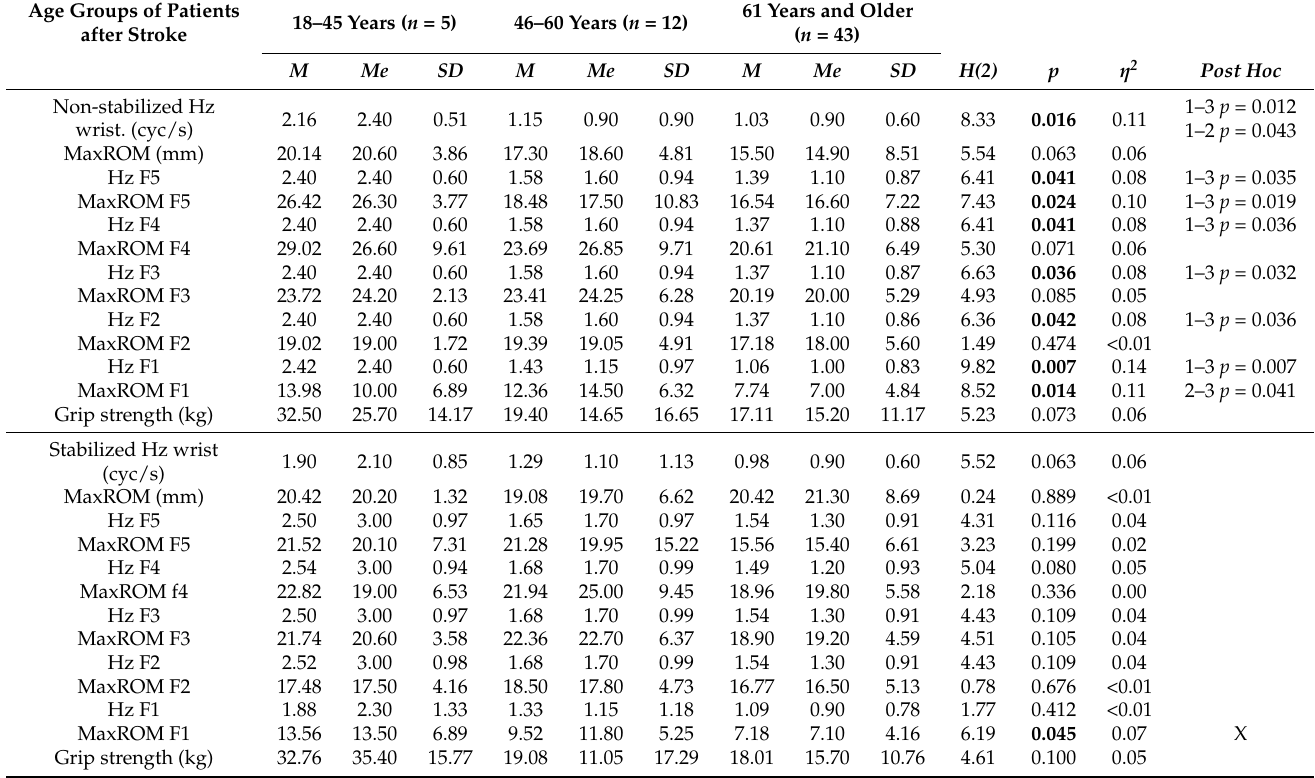
Table 3. Comparison of age groups of patients after stroke, in terms of the parameters measured in the unstable and stabilized position.